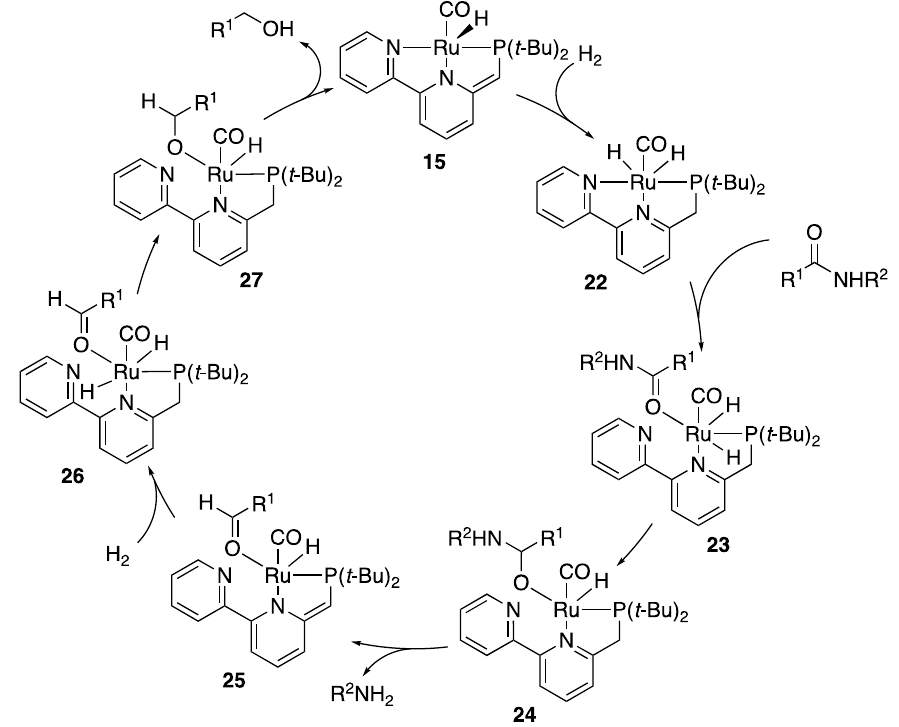
Scheme 11. Proposed mechanism for Ru-pincer complex 15 -catalyzed hydrogenation of amides to alcohols and